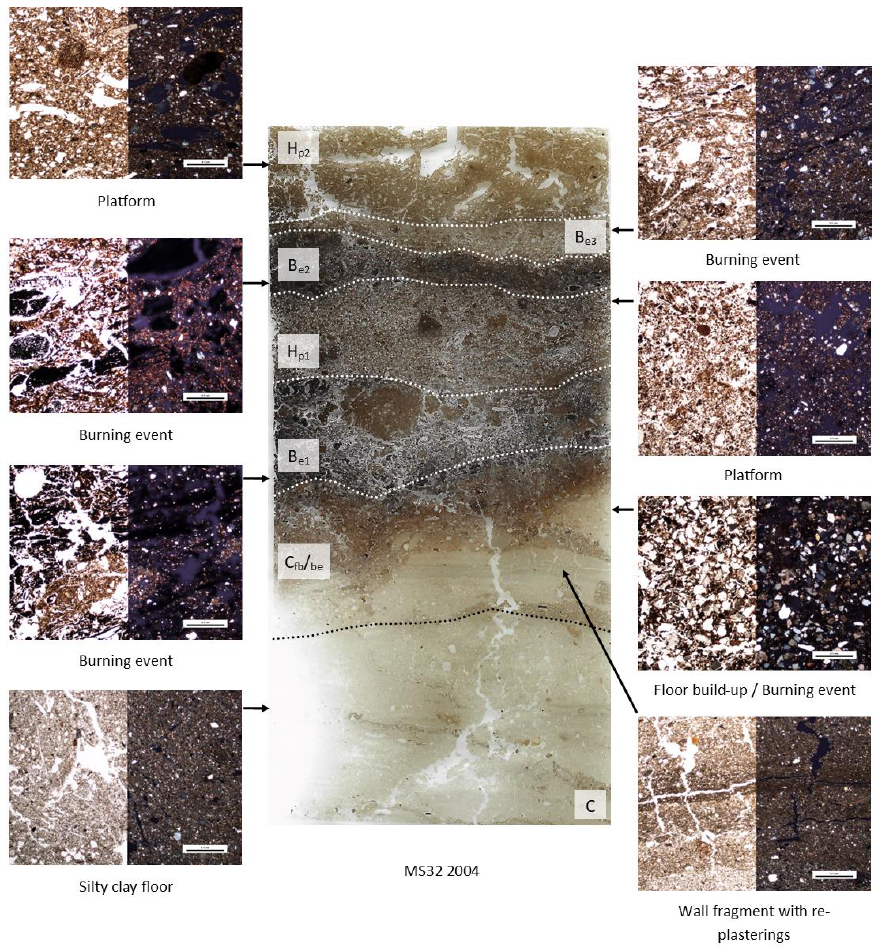
Figure 5. Thin section (MS32 2004) showing the two platforms of the hearth (Hp1 and Hp2) and the four burning events (Cfb/Be, Be1, Be2, and Be3). The scale bar in the microphotographs is 0.1 cm.